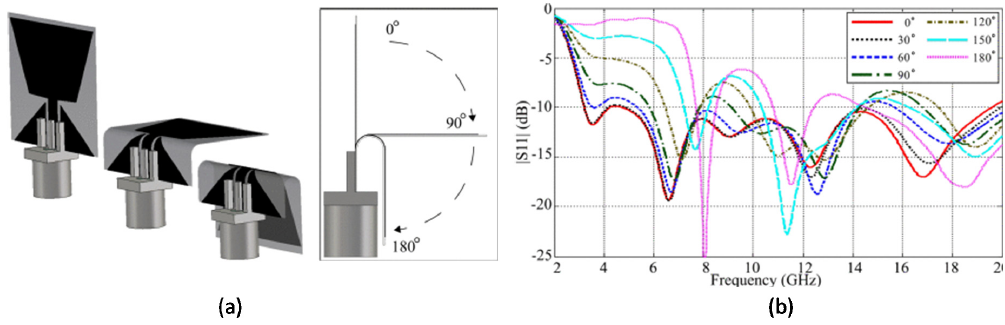
Figure 18. Impact of bending on antenna performance. ( a ) 3-D bending setup and definition of the bending angle in CST microwave studio, and ( b ) simulated | S 11 | for di ff erent bending angles [42].